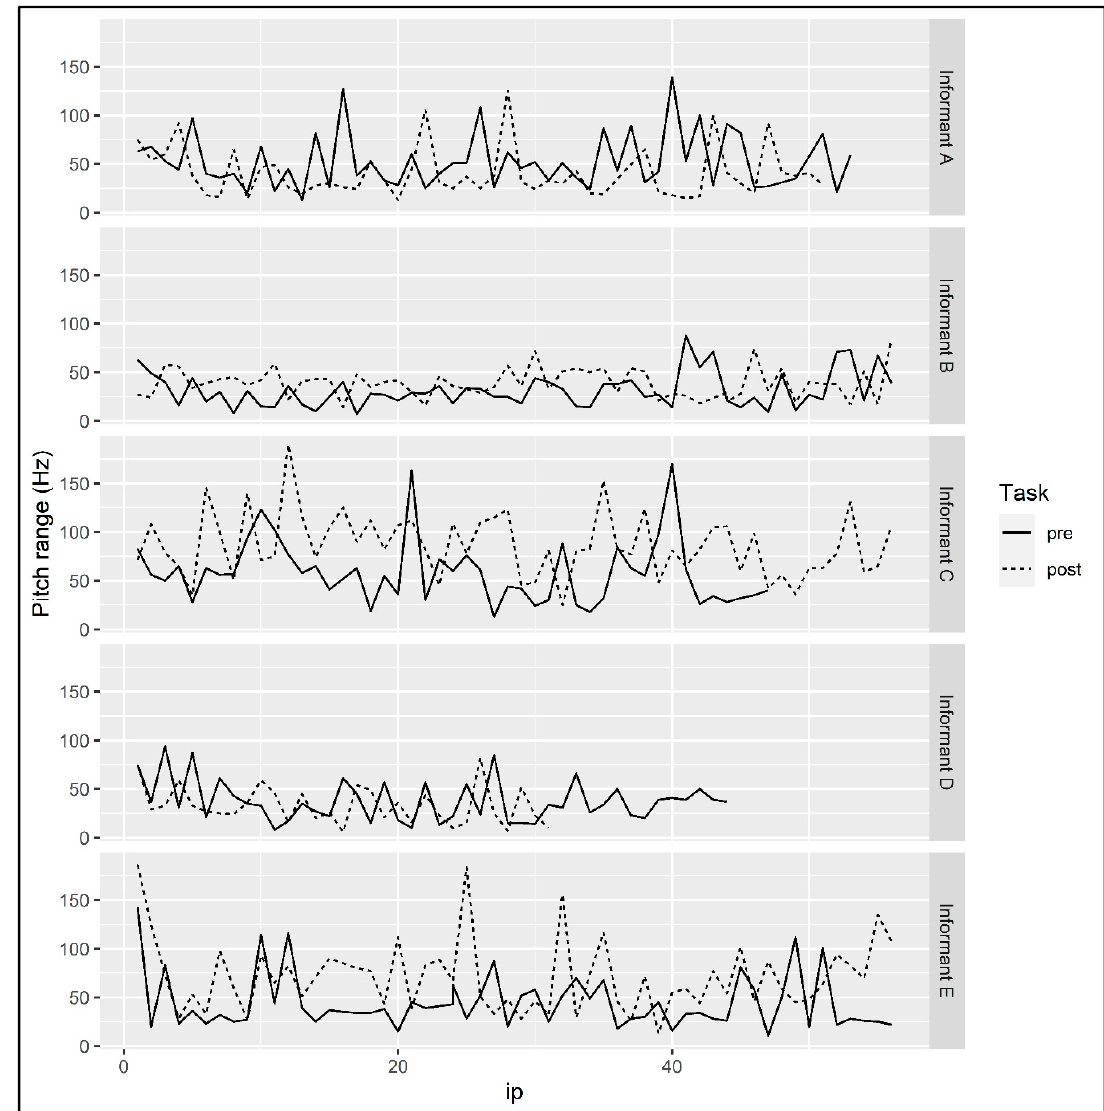
Figure 14. Pitch range over the course of the narrative for each informant.